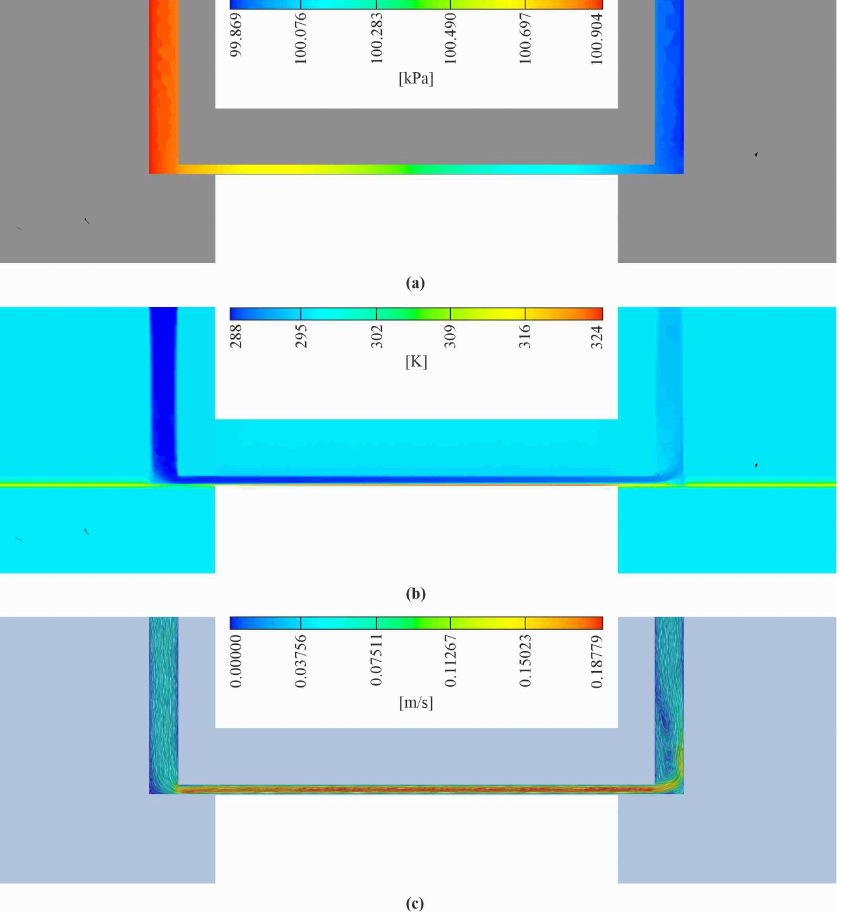
Figure 6. Two ‐ dimensional results from the calculations showing the distributions of: ( a ) absolute pressure, ( b ) temperature, and ( c ) velocity (screenshots from Simcenter STAR ‐ CCM+ software); the data shown for the longitudinal symmetry axis of the test section.